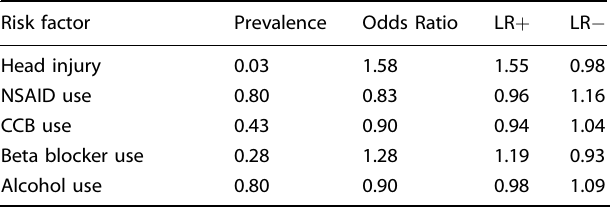
Table 1. Prevalence, odds ratios 5 and likelihood ratios for a positive (LR + ) or negative (LR-) association with PD for risk factors (ever versus never) without previous estimates.